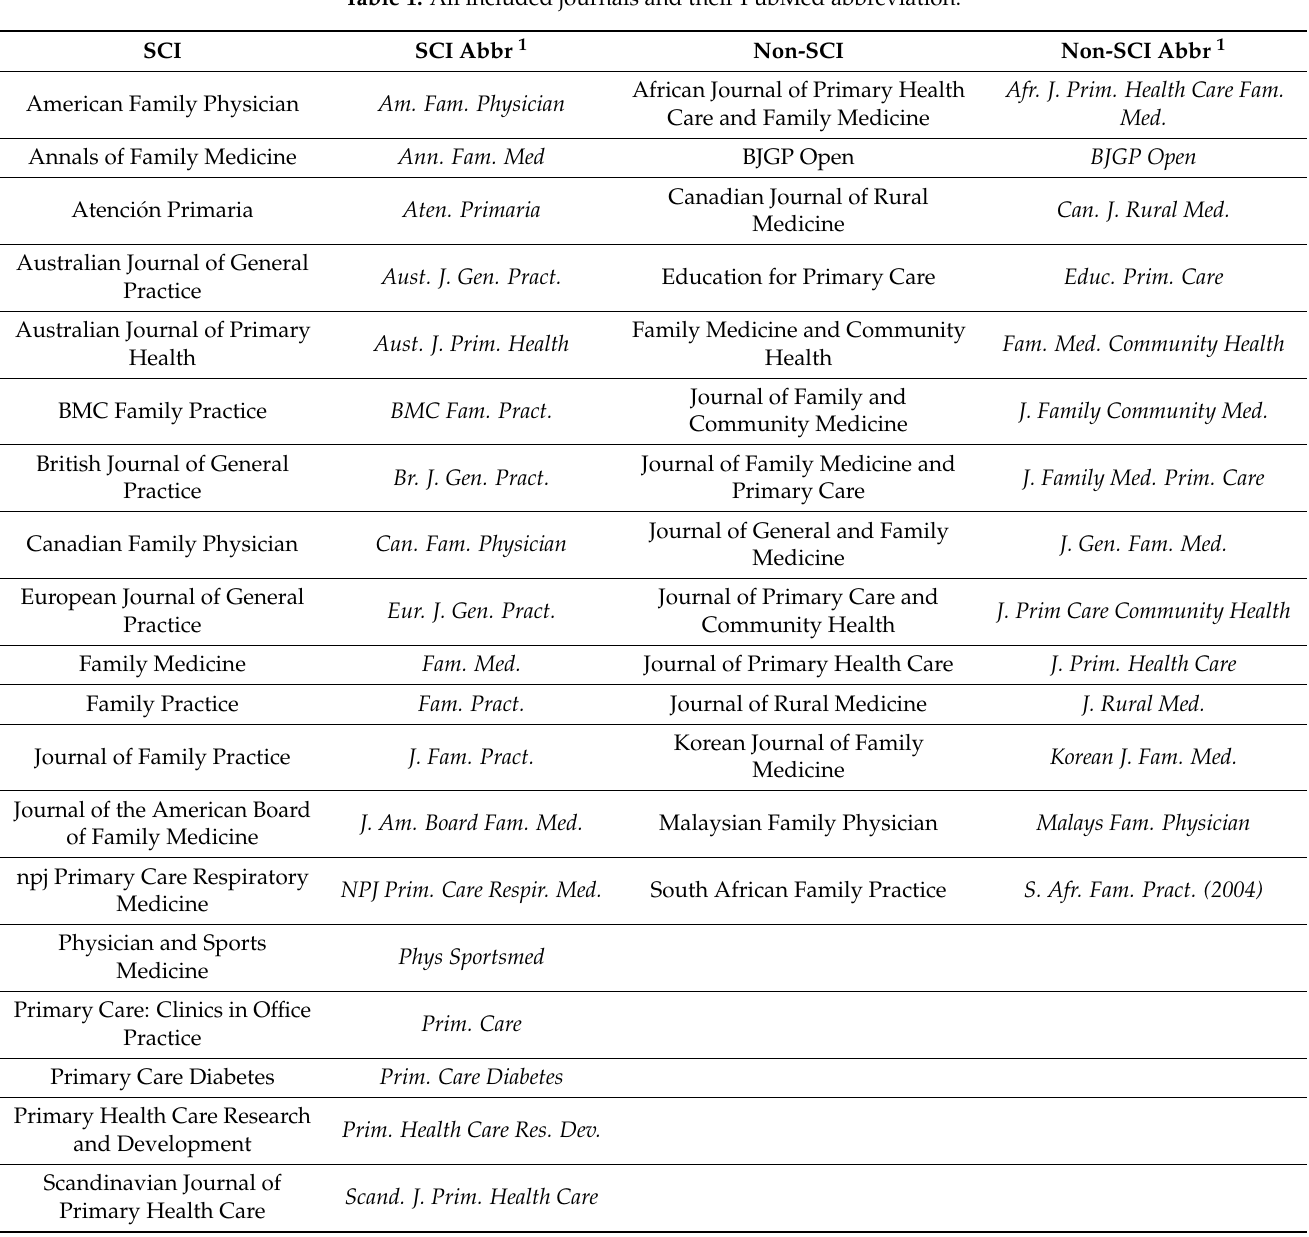
Table 1. All included journals and their PubMed